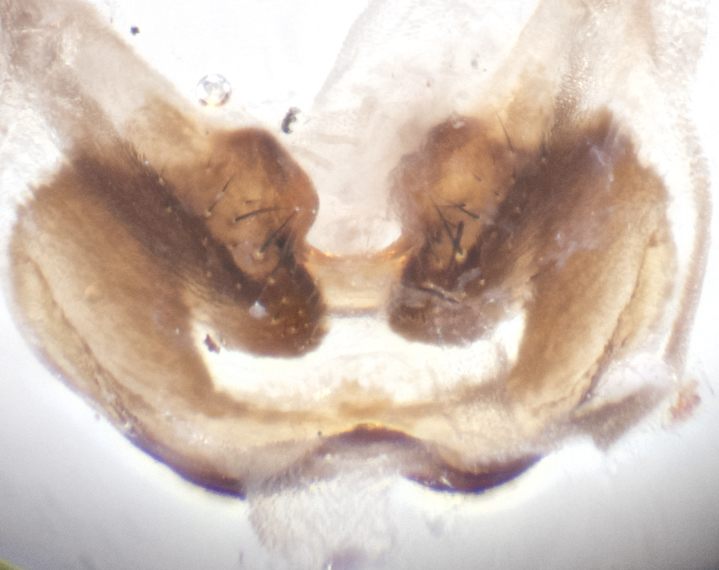
sternite 5, ventral view